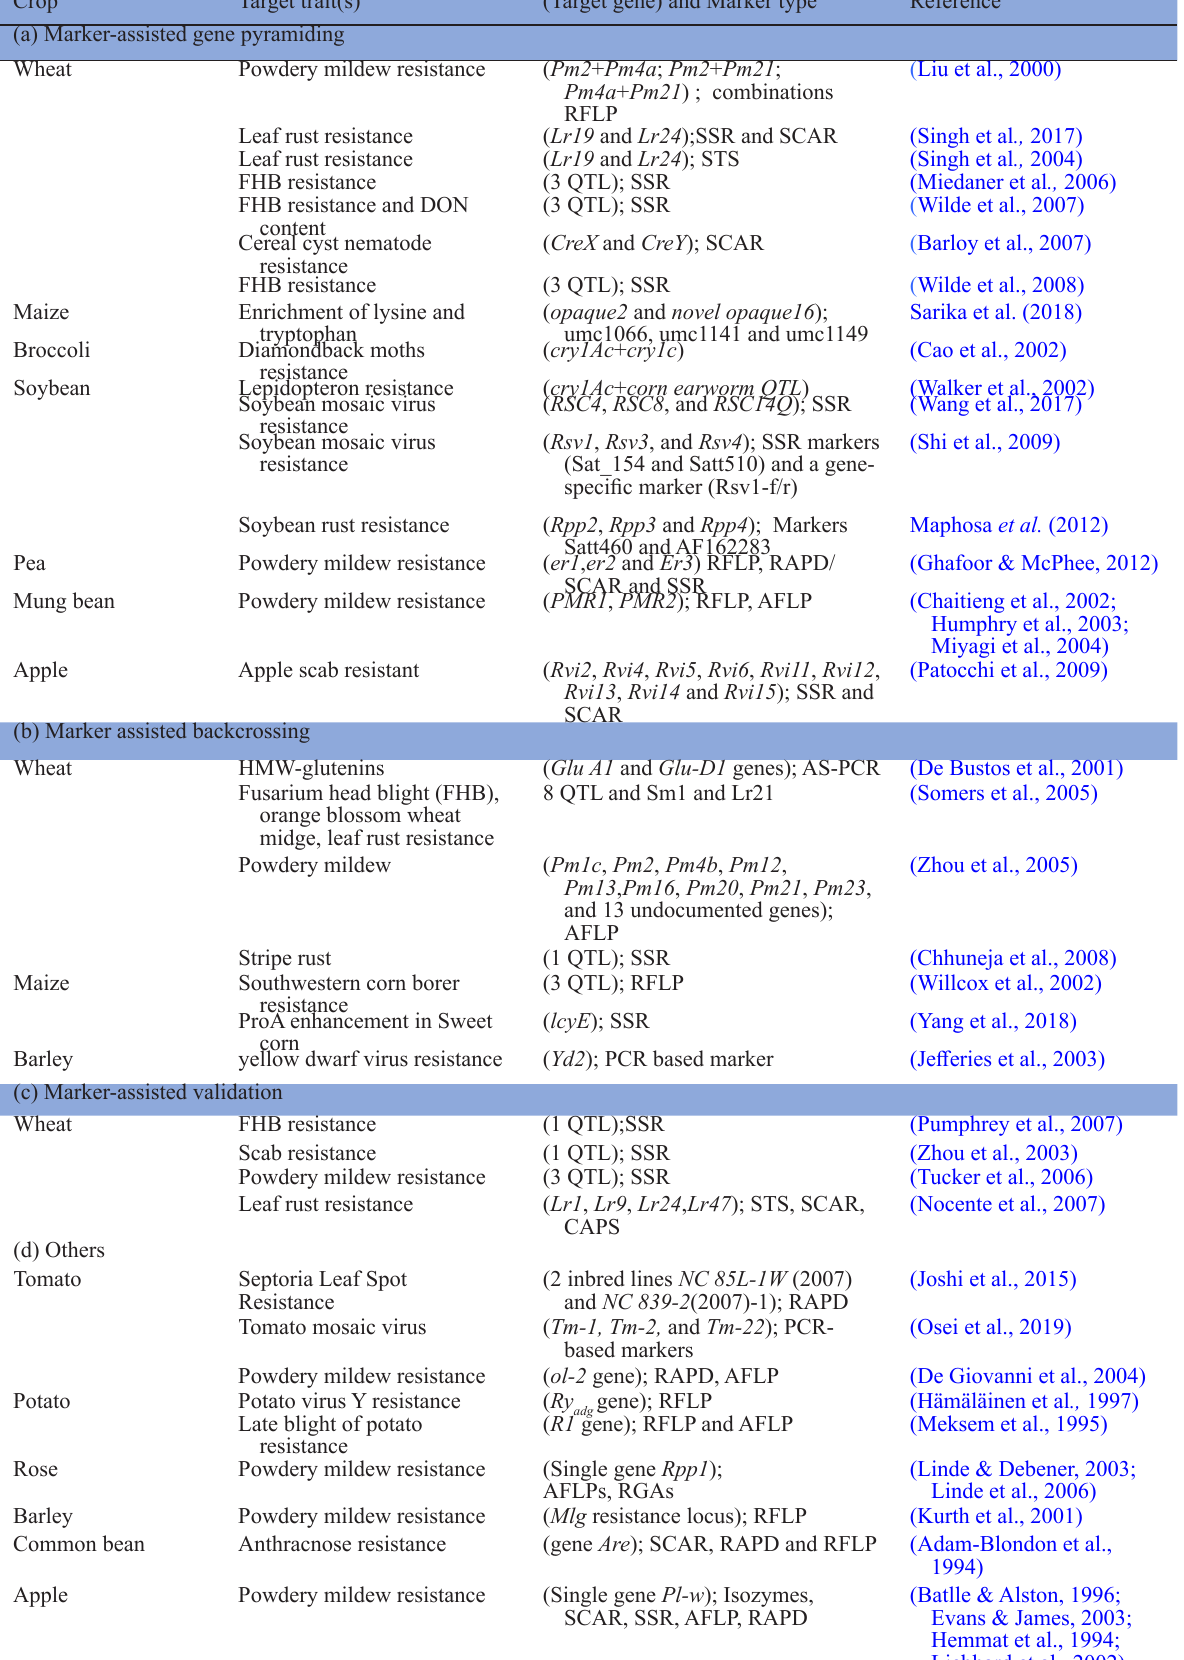
Table 3. Breeding works on various crops using